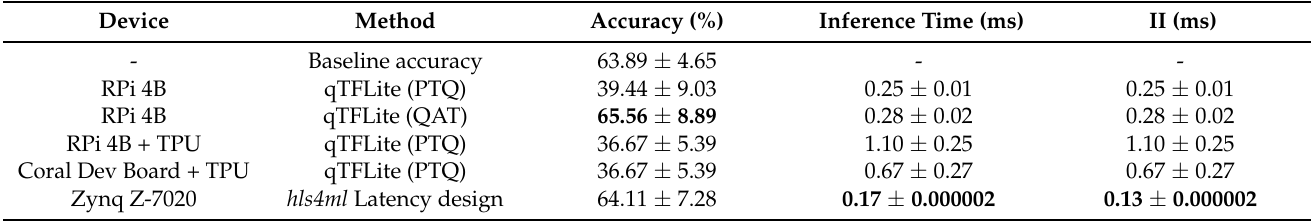
Table 8. CNN1D: Zynq Z-7020 vs. other embedded devices for the BDLib dataset.